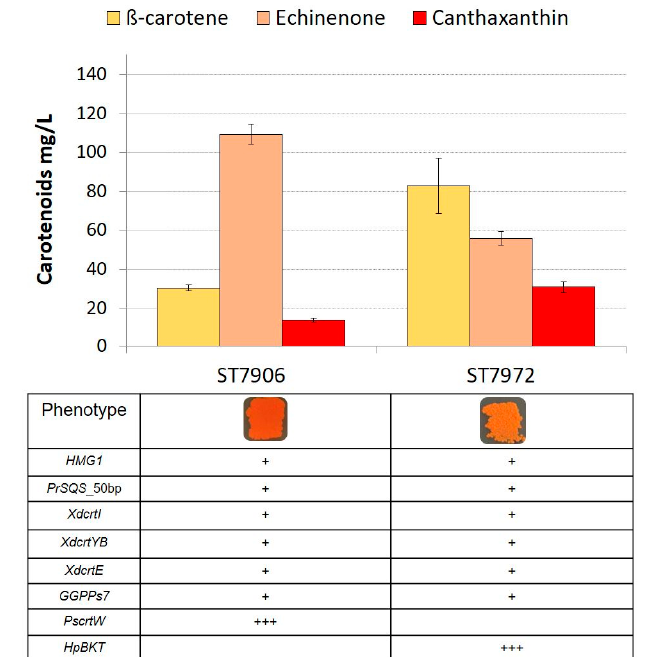
Figure 2. Carotenoid production of strains ST7906 (expressing multiple copies of PscrtW ) and ST7972 (expressing multiple copies of HpBKT ). All strains were cultivated in YP + 8% glucose in 24-deep-well plates for 72 h. The error bars represent standard deviations calculated from triplicate experiments.